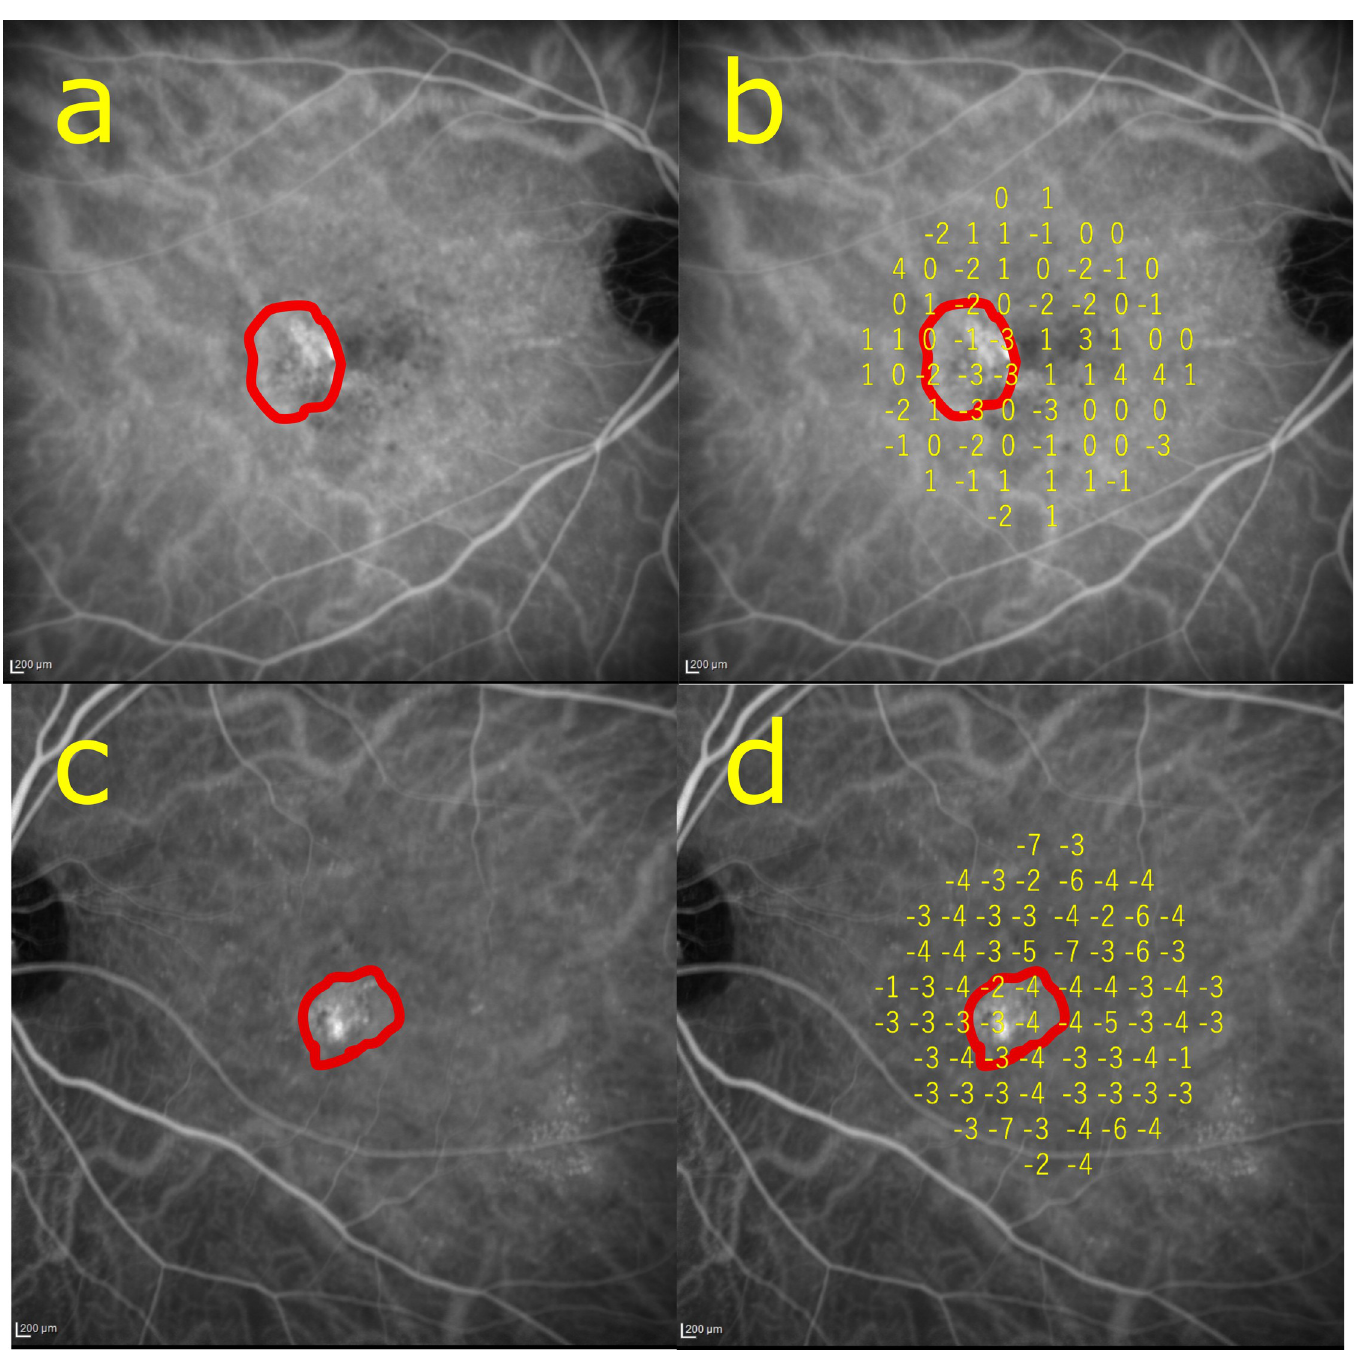
Fig 3. Representative images of the CVH and superimposing retinal sensitivity in eyes with or without CNV. (a,b) The right eye of a 56-year-old patient. CNV was detected within the CVH area. (a) Intermediate phase of ICGA revealed the CVH area (red line). (b) Retinal sensitivity was superimposed on a. The difference in average sensitivities between the inside and outside of CVH was -2.21. (c,d) The left eye of a 68-year-old patient. CNV was not detected within the CVH area. (c) Intermediate phase of ICGA revealed the CVH area (red line). (d) Retinal sensitivity was superimposed on c. The difference in average sensitivities between the inside and outside of CVH was